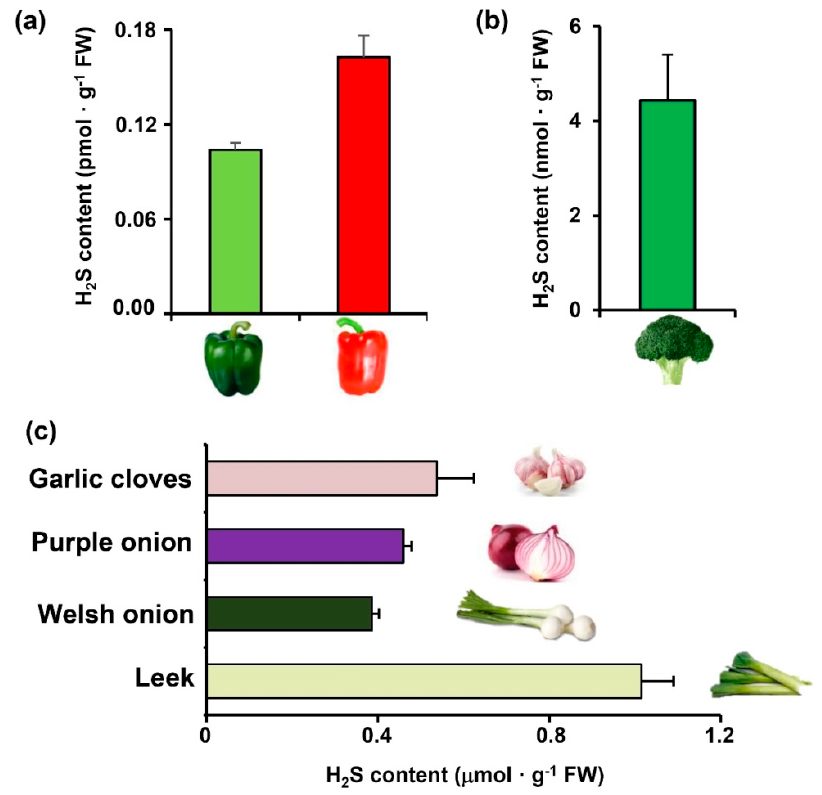
Figure 1. Endogenous H 2 S detection in different plant species including ( a ) sweet pepper ( Capsicum annuum L.) fruit at distinct ripening stages (fully green and fully red), ( b ) Broccoli ( Brassica oleracea var. Itálica), ( c ) Allium species including garlic ( Allium sativum L.) cloves, leek ( Allium ampeloprasum var. porrum), welsh onion ( Allium fistulosum ), and purple onion ( Allium cepa ). H 2 S was detected using a micro sulfide ion electrode.